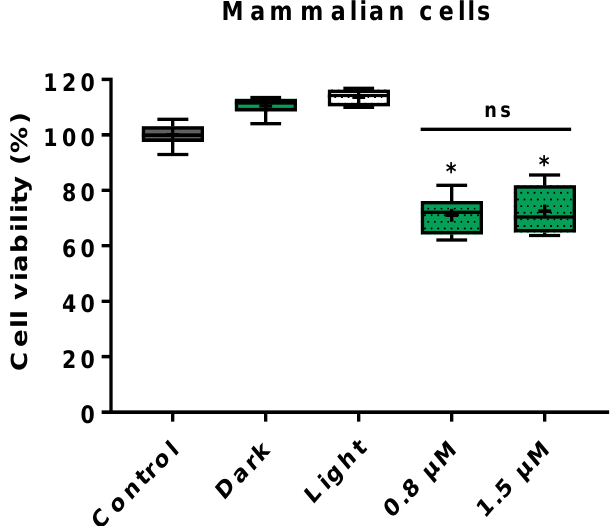
Figure 5. Box plot of cell viability of Vero cells assessed through MTT assay following treatment. Control: untreated cells; dark: cells incubated with 1.5 µ M of ZnP without irradiation; light: cells irradiated in PBS only (4.3 J/cm 2 ). Photodynamic treatment was performed for cells incubated with 0.8 or 1.5 µ M of ZnP for 10 min followed by irradiation (4.3 J/cm 2 ). The results were expressed in relation to untreated samples. Differences between groups were analyzed by Mann–Whitney test and considered significant at p < 0.05). At least three independent experiments were performed. *: p < 0.05 compared to control. ns: not significantly different, p > 0.05.